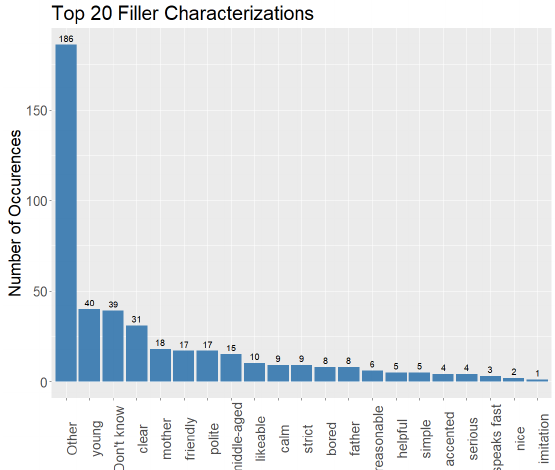
Figure A1. Twenty most common characterizations about filler speakers as offered by experiment participants. Arranged in descending order.